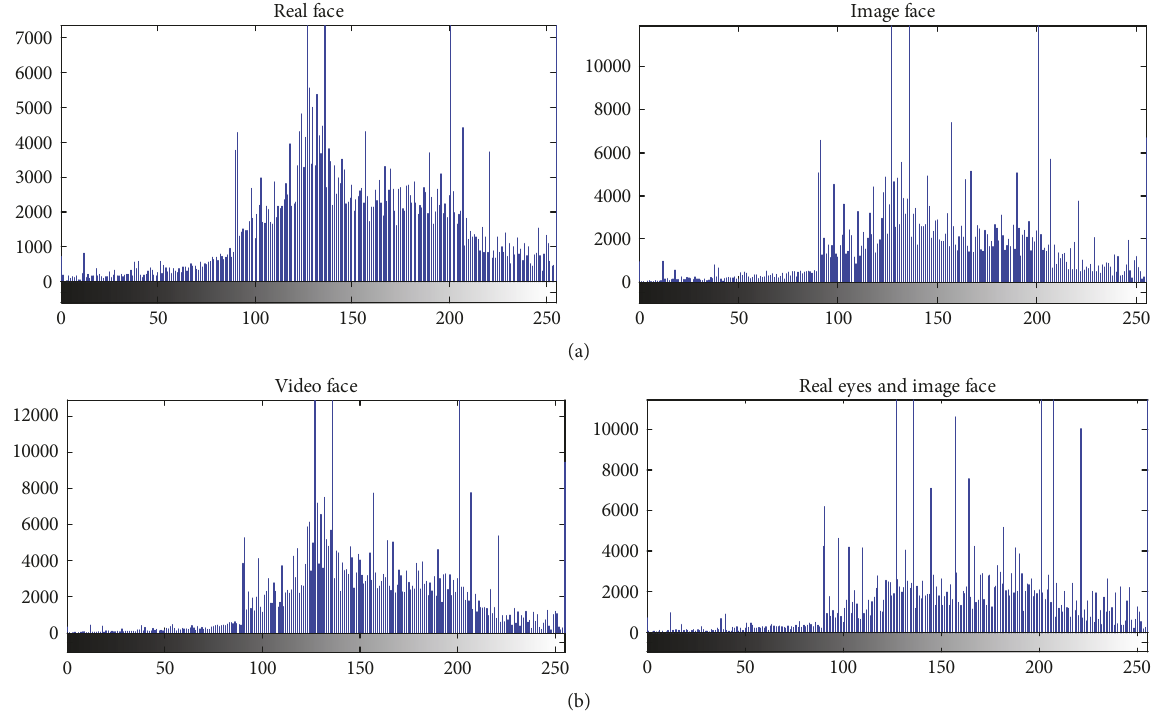
Figure 9: Histogram with different attack methods. The top image shows the features with the real face and the image attack face. The bottom image is the feature with the video attack face and image face with real eyes.